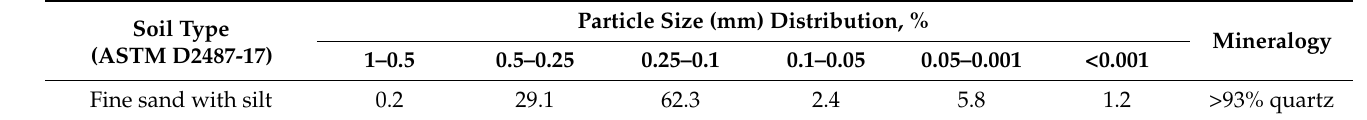
Table 1. Particle size distribution of sand samples.